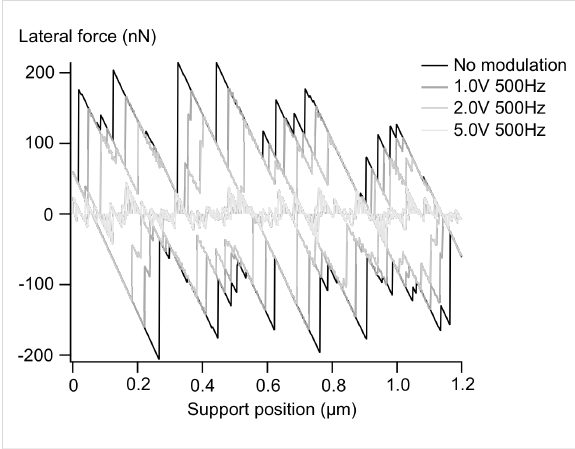
Figure 9: The major features of the experiment shown in Figure 8, including the amplitude reduction and the visibility of the modulation signal in the lateral force, are replicated in a simulation with the stochastic Prandtl–Tomlinson model of different modulation ampli- tudes. The peaks in the measurement appear blunter, most probably due to small-scale